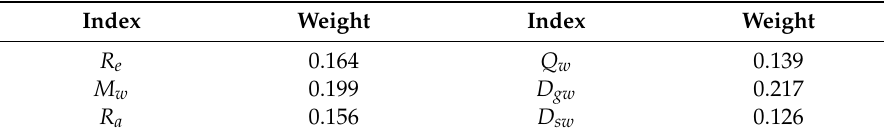
Table 5. Annual AWRCC set pair analysis results of the Haihe district provinces and cities. Table 4. Evaluation factors weights calculated by the entropy weight method.